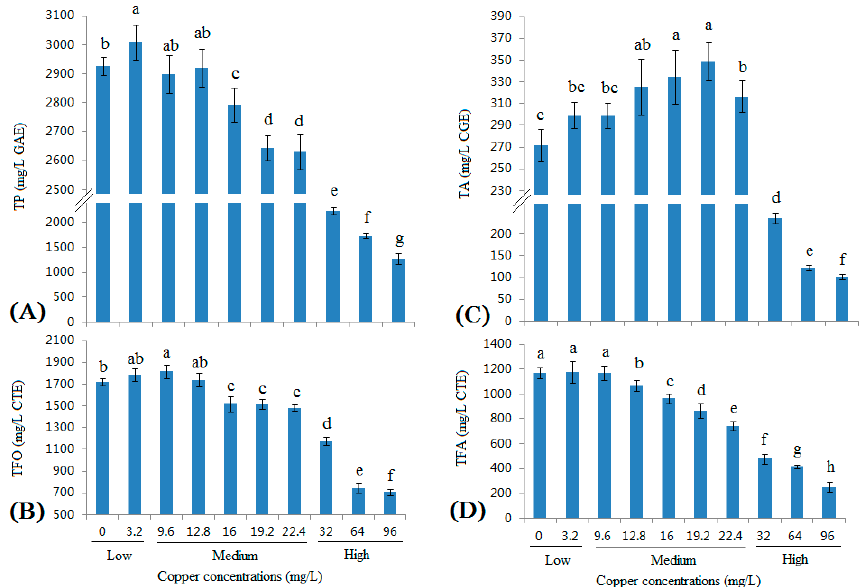
Figure 1. Changes in the TP (Total polyphenol) ( A ), TFO (total flavan-3-ol) ( B ), TFA (total flavonoid) ( C ), and TA (total anthocyanin) ( D ) contents in wine with different copper concentrations. Different letters indicate statistically significant differences (Duncan’s multiple range test, p < 0.05) between samples with different copper concentrations.